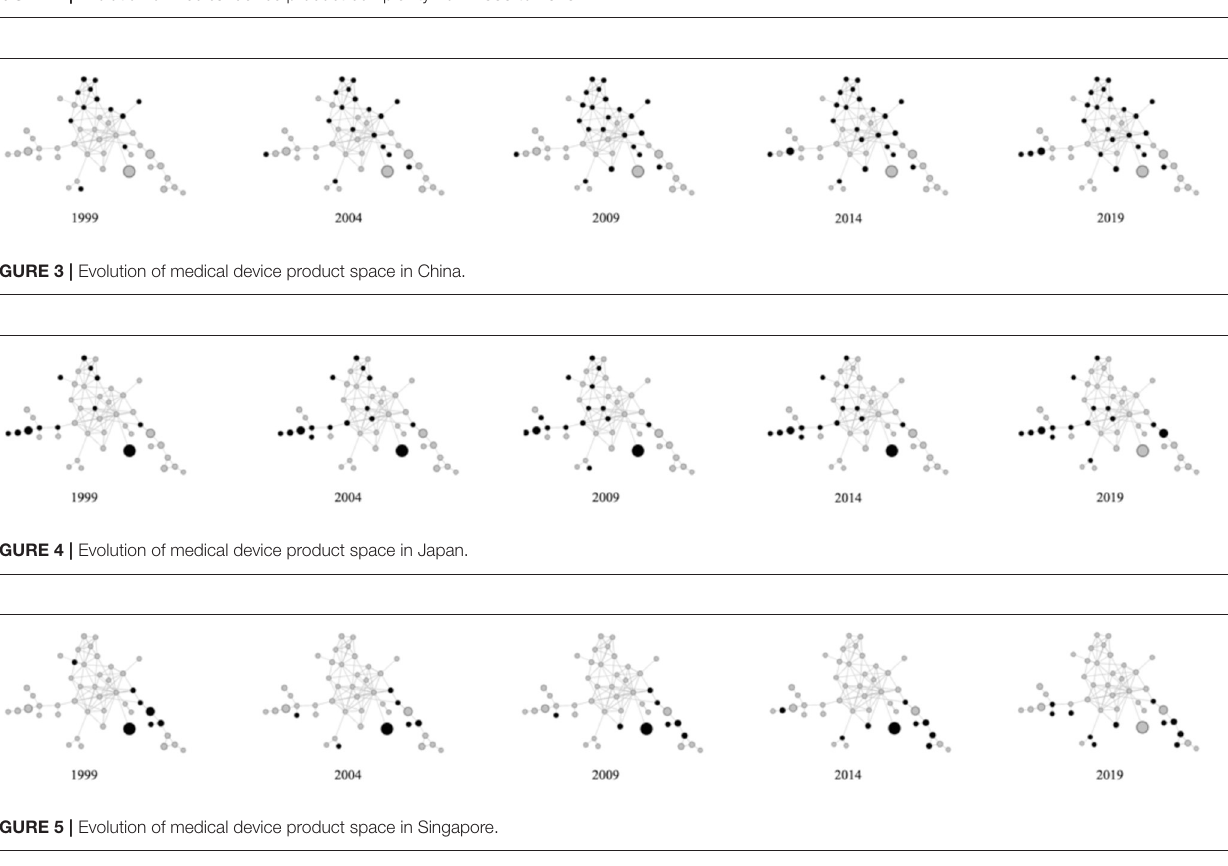
FIGURE 2 | Evolution of medical device product complexity from 1999 to 2019.